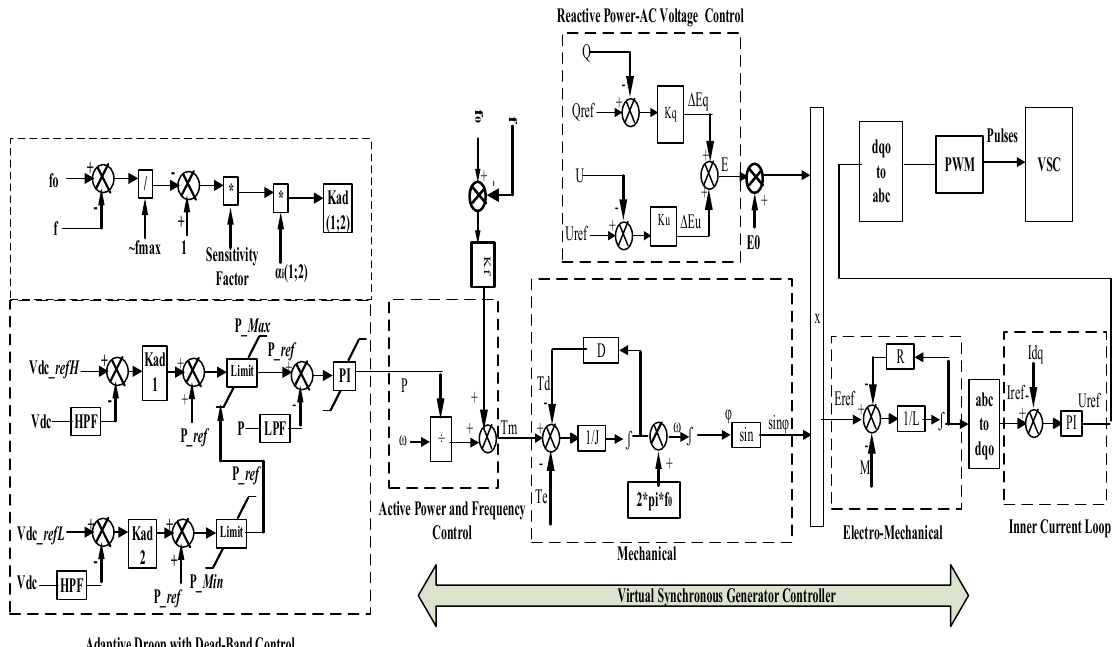
Figure 3. Adaptive droop with a dead-band and VSG.